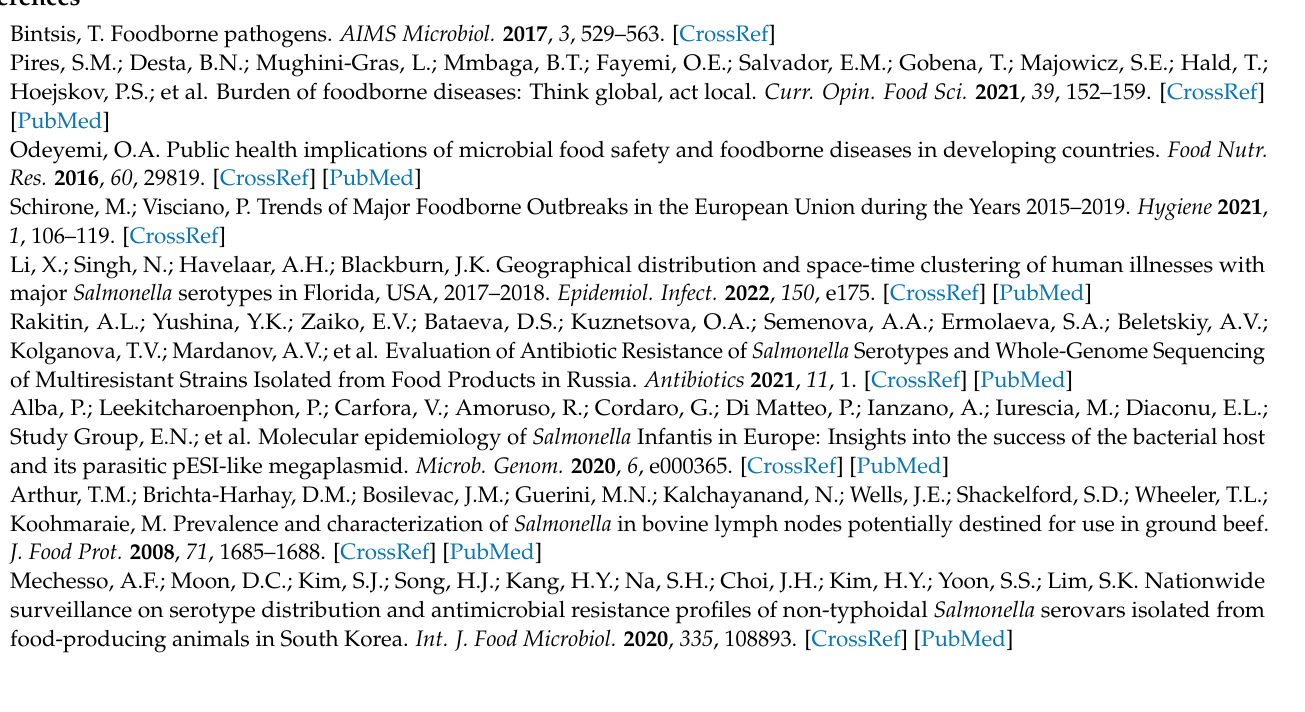
Table S4: Plasmids determined by hybrid assembly with AMR and virulence genes shown for four representative S. enterica